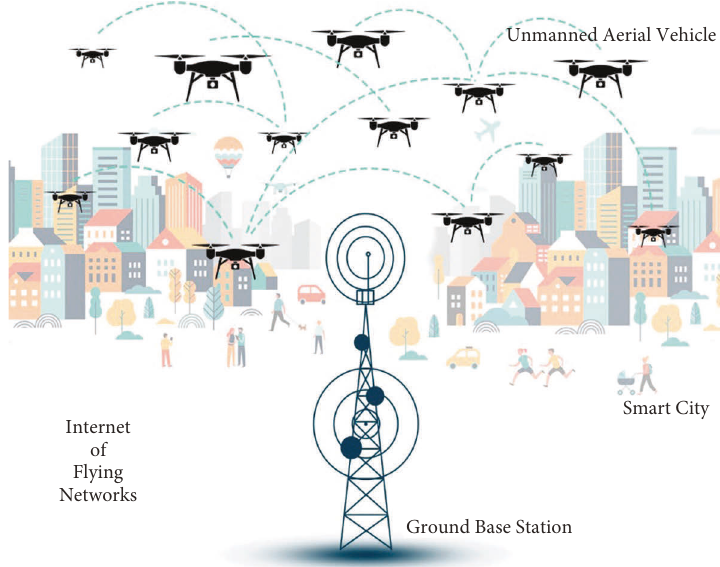
Figure 4: Secure communication using Internet of flying